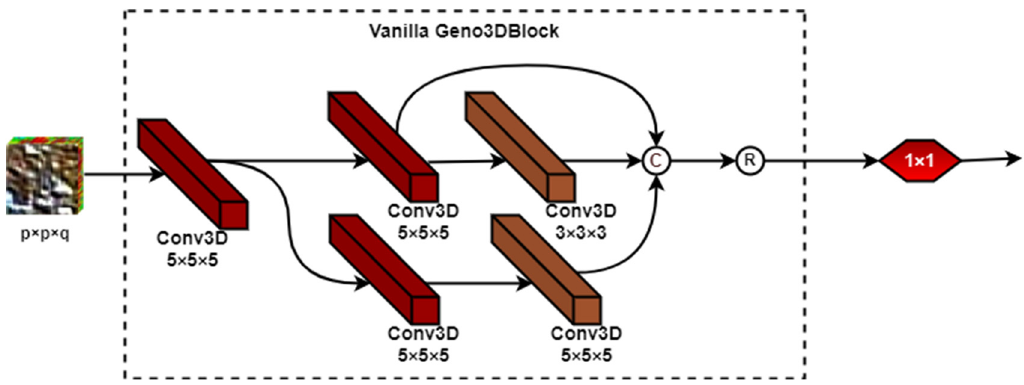
Figure 5. Framework of Geno3Dblock-Vanilla.